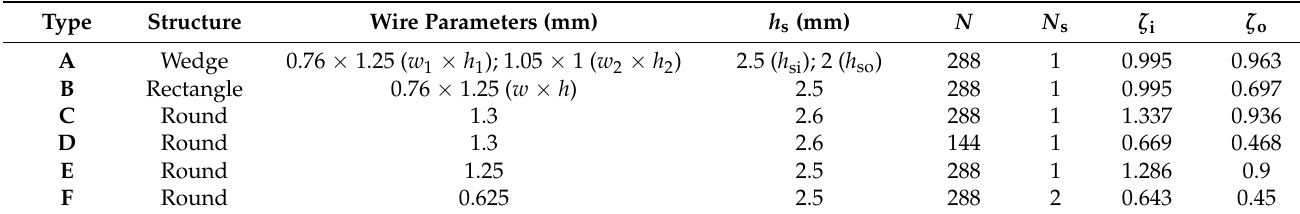
Table 2. Calculation results of filling factor of different effective conductors.